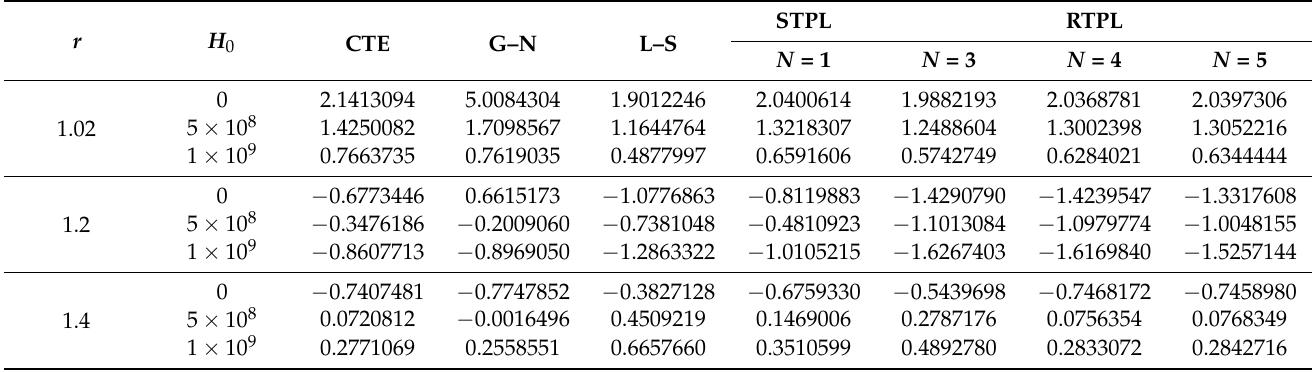
Table 9. Different thermoelasticity theories with a range of r values show the effects of dimensionless magnetic field intensity H 0 on radial stress σ rr .